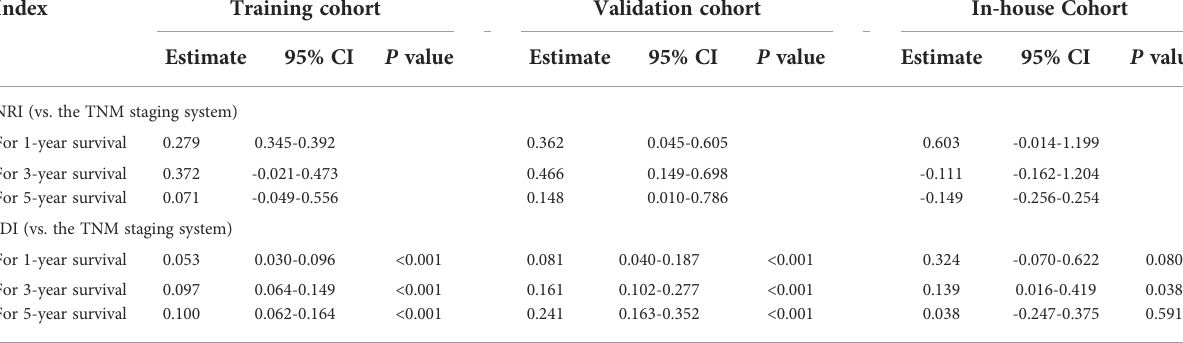
TABLE 3 NRI and IDI of the nomogram versus the TNM staging system for predicting OS of patients with